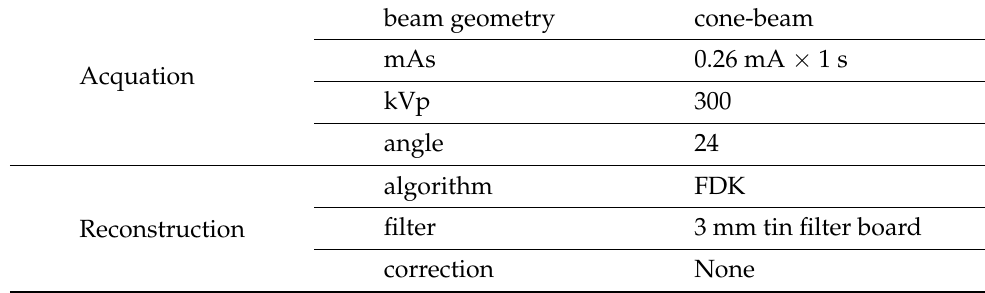
Table 1. The details of the acquisition and reconstruction